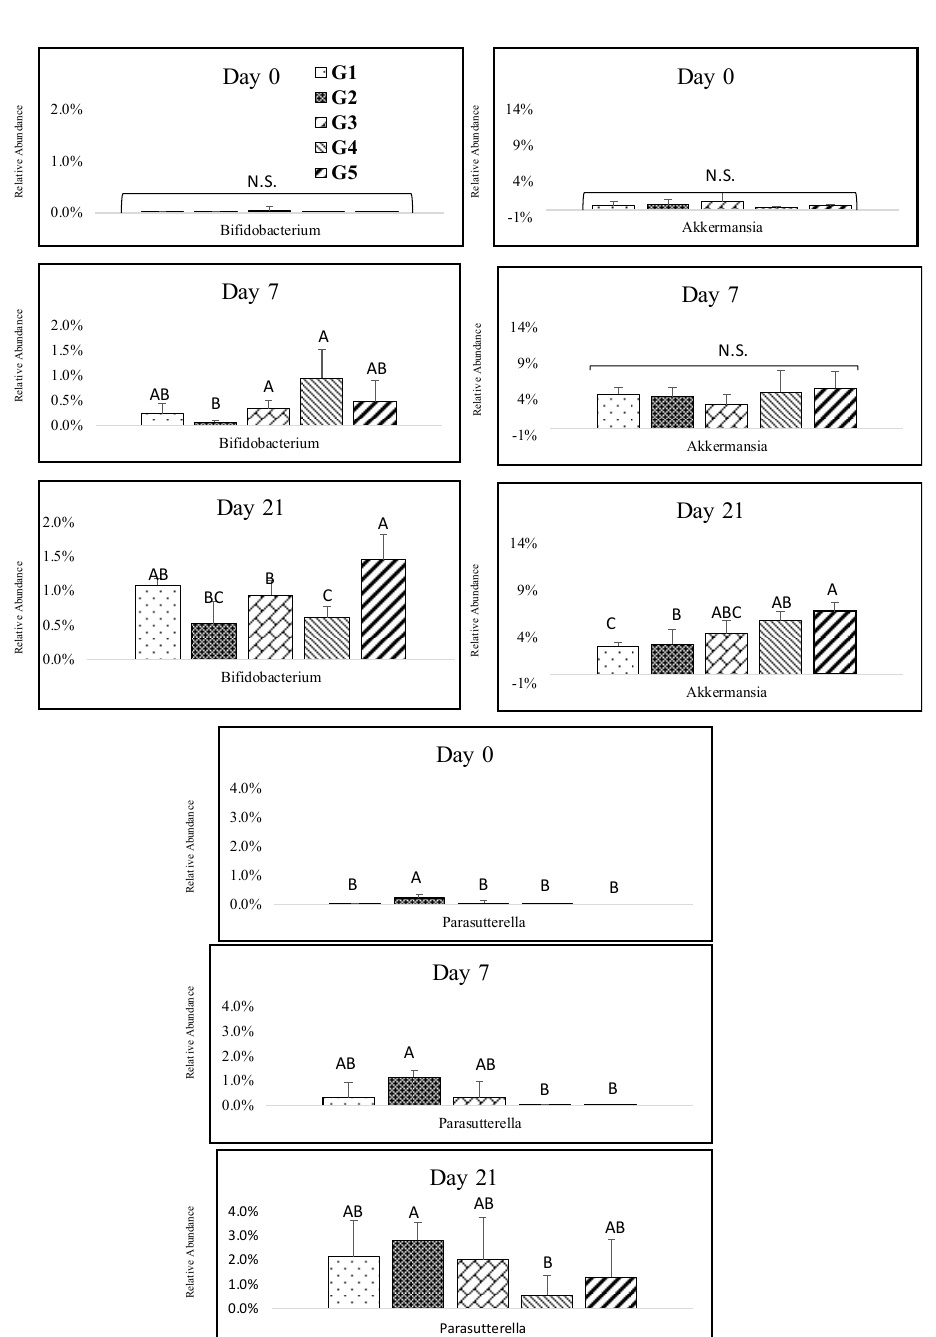
Figure 5. Impact of melanoidin malts on responsive genera relative abundances among the other phyla. Actinobacteria ( Bifidobacterium ), Verrumicrobia ( Akkermansia ), and Proteobacteria ( Parasutturella ). Significant differences ( p < 0.005) are indicated by different letters ( n = 5). The relative abundance of several Firmicutes genera ( Clostridium XIVb and Lactobacillus ), as well as Bifidobacterium (Supplementary Figure S3) and Akkermansia (Supplementary Figure S3) were increased significantly in all groups that consumed 0%, 25%, 50%, 75%, and 100% of melanoidin malts throughout the study from day 0 to day 21, and there were slight or significant differences among the days ( p < 0.005). Significant increases in Parasutterella were present in the mice that were fed 0%, 25%, and 50% melanoidin malts during the study, but the relative abundance of Parasutterella was lower in groups that received 75% and 100% melanoidin malts throughout the study from day 0 to day 2, and there were no or only slight differences among the days Supplementary Figure S3).